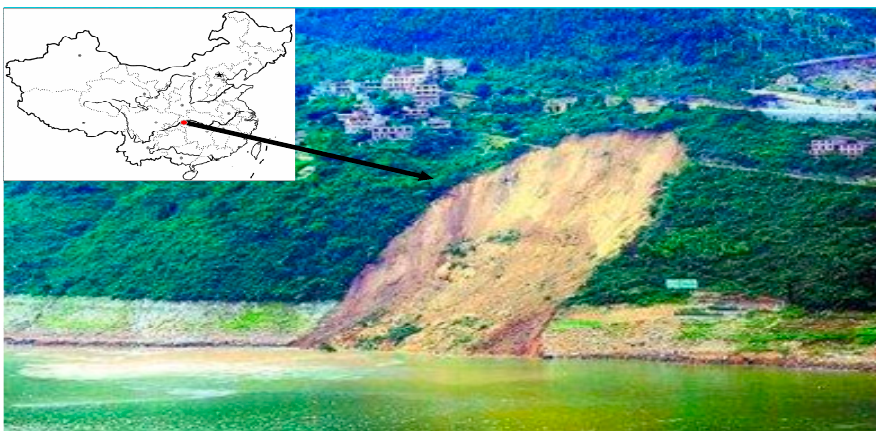
Figure 5. Location of the Dashuitian landslide in China.